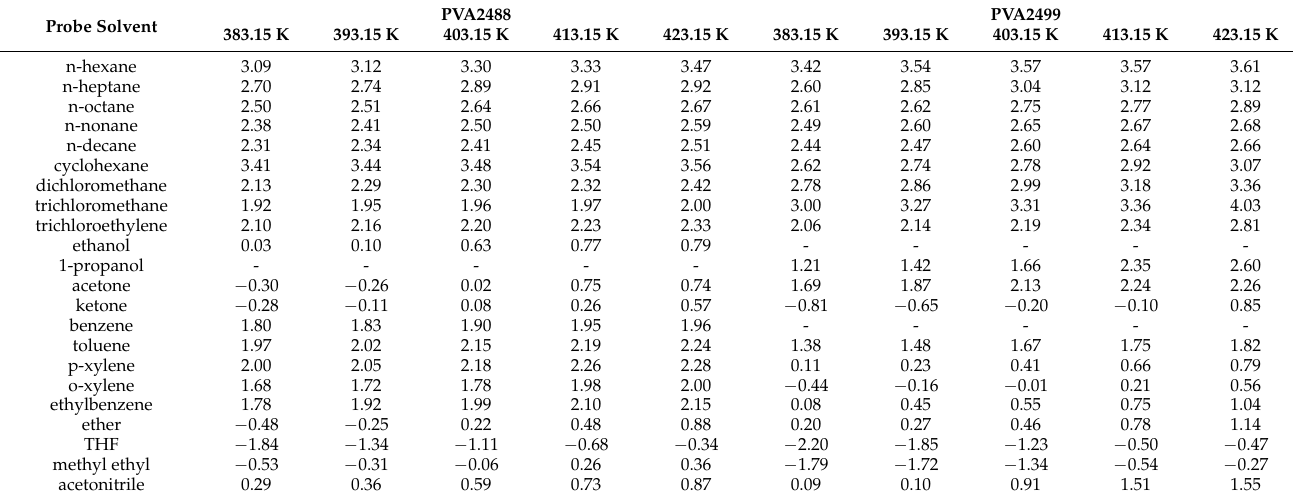
Table 4. Flory–Huggins interaction parameters of probe solvent and PVA at different